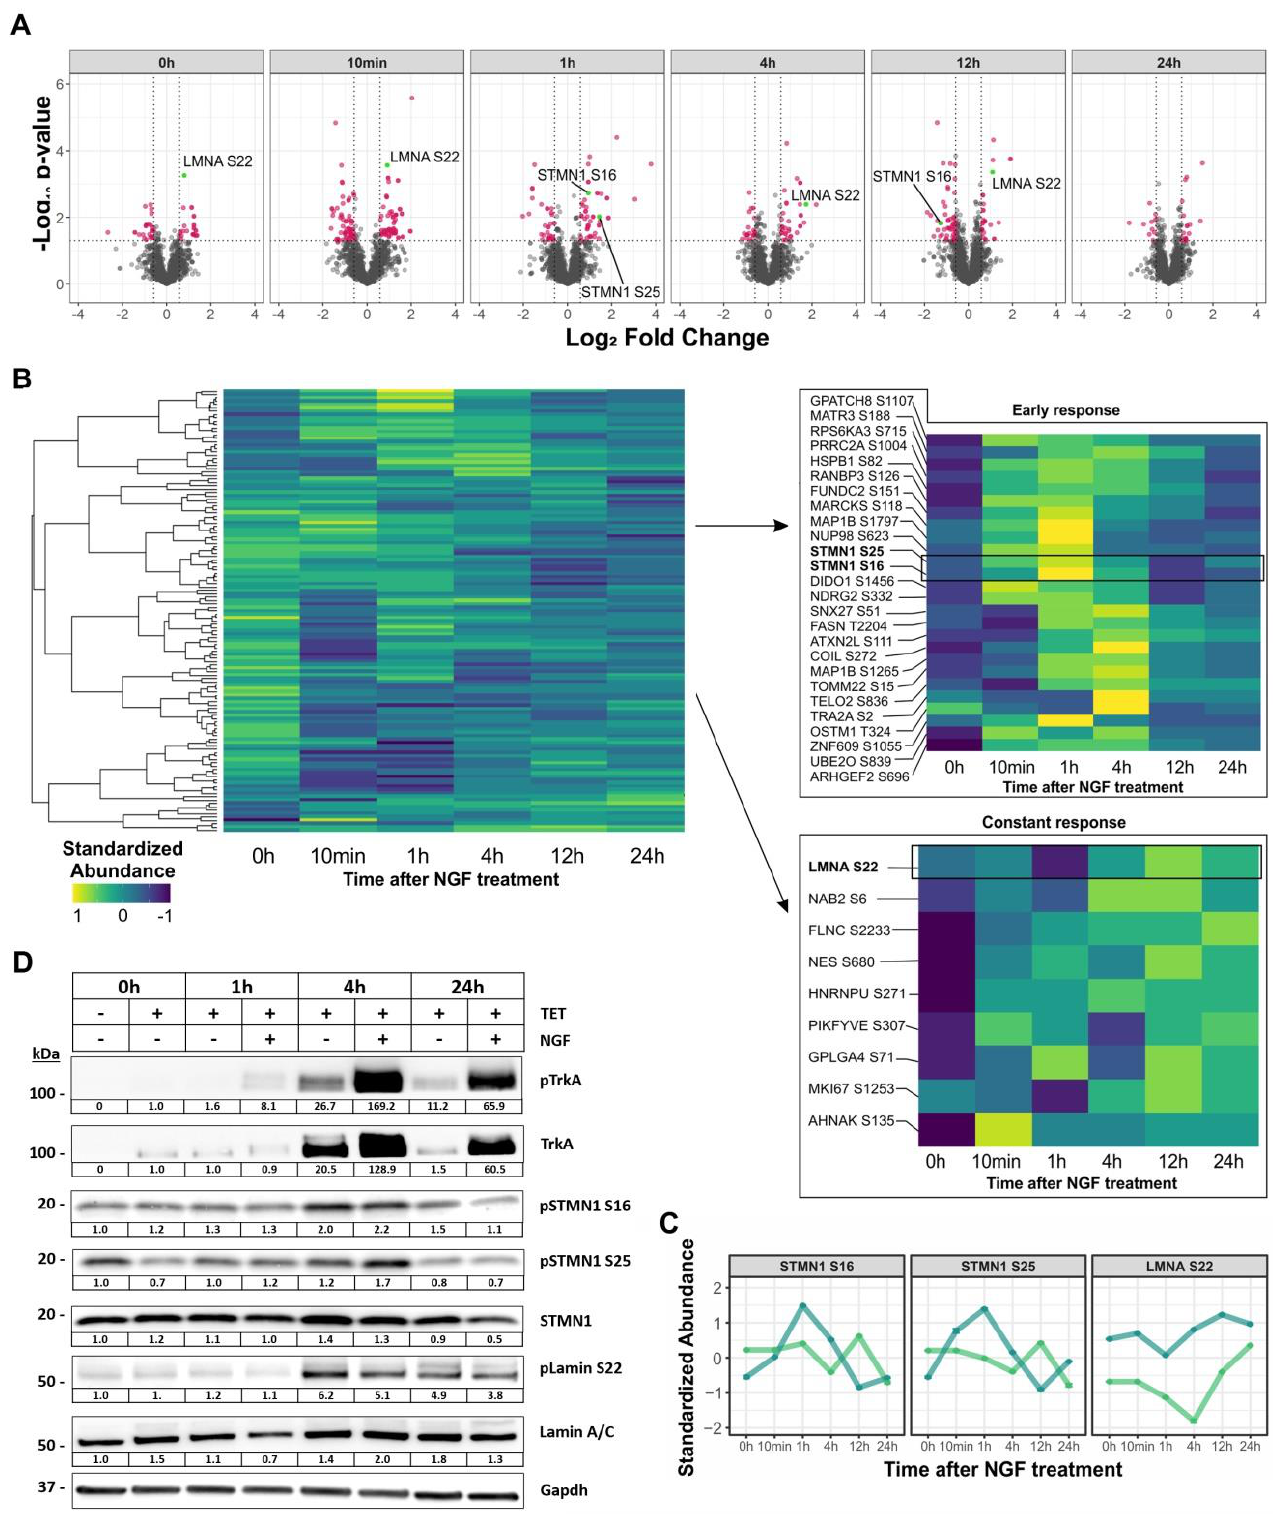
Figure 4 . Phosphorylation dynamics induced by NGF − mediated NTRK1 activation in IMR5 cells. ( A ) Volcano plots representing the results of differential phosphoproteome analysis for the time points indicated. Significantly regulated p-sites are highlighted in red ( p - value ≤ 0.05; −1.5 ≤ FC ≥ 1.5) and prominently regulated p -sites are highlighted in green. ( B ) Heatmaps representing hierarchical cluster analysis (Pearson correlation, complete linkage) of significantly regulated p-sites. Magnifications show clusters of p-sites with early and constantly increasing abundance, respectively. ( C ) Regulation profiles of selected p-sites in NGF-treated cells (blue) compared to untreated controls (green). ( D ) Orthogonal validation of selected phosphorylation target sites shown in ( C ) using Western blot analyses of independent experiments. Cells were